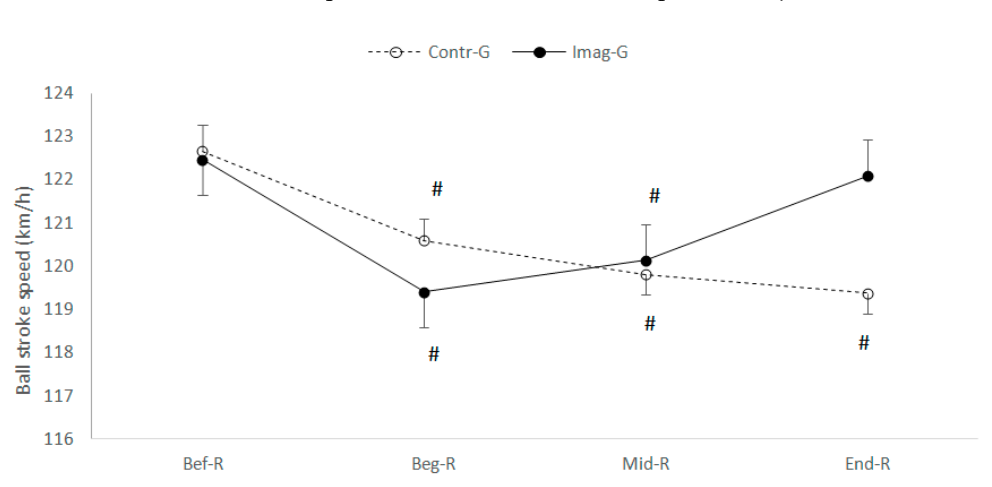
Figure 4. Mean and standard deviation of the ball stroke speed, before, during and at the end of Ramadan for both groups (CG vs. IMG). # Significantly di ff erent from Bef-R at p < 0.001. Ramadan for both groups (CG vs. IMG). # Significantly different from Bef-R at p < 0.001. Regarding the difference between the groups, no significant difference was identified for the ball stroke speed (F (1.36) = 0.19; p = 0.667; η (cid:2926)(cid:2870) = 0.005), as shown in Figure 4. (accuracy × ball run speed), revealed a significant interaction of the (Ramadan Period (Before / at the